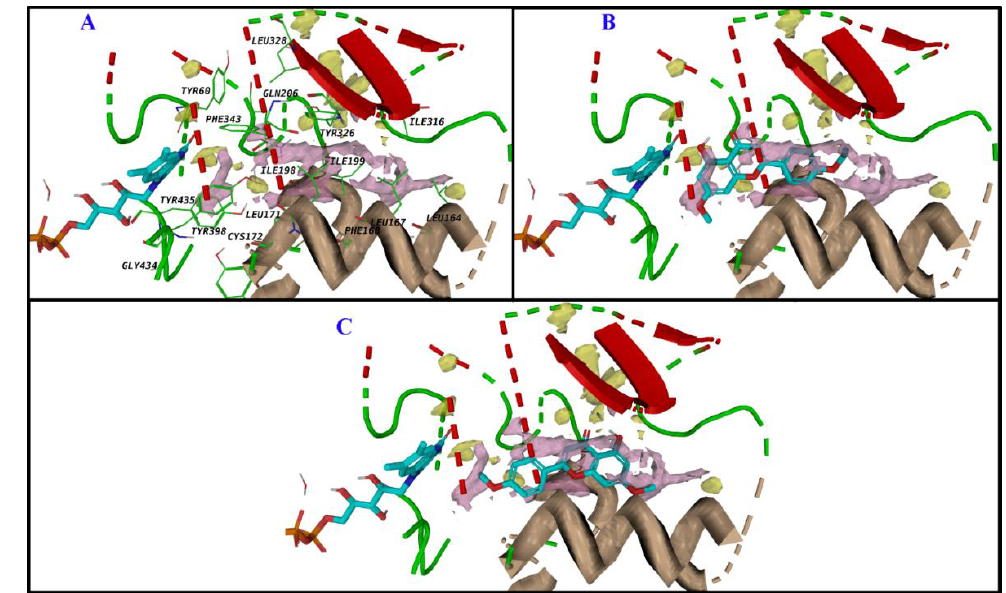
Figure 4. The 2D protein – ligand contacts for pose 1 ( A ) and pose 2 ( B ) for acacetin 7- O -methyl ether.